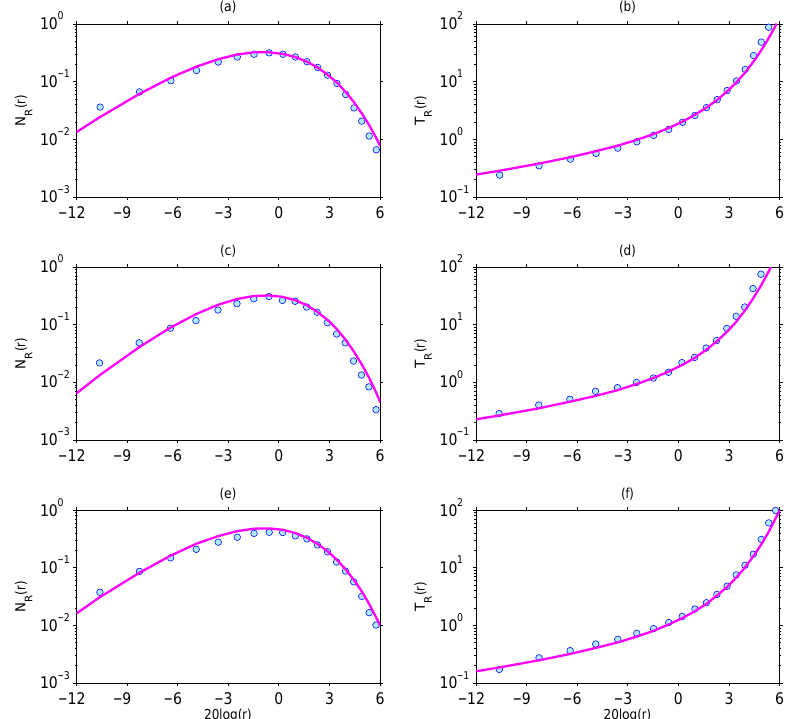
Figure 8. Empirical LCR (crossings per second; panels a, c, e ) and AFD (in seconds; panels b, d, f ) during the three distinct phases of solar activity level versus the scintillation severity as estimated by the theoretical α − µ model (Eq. 5) for S 4 = 0 .